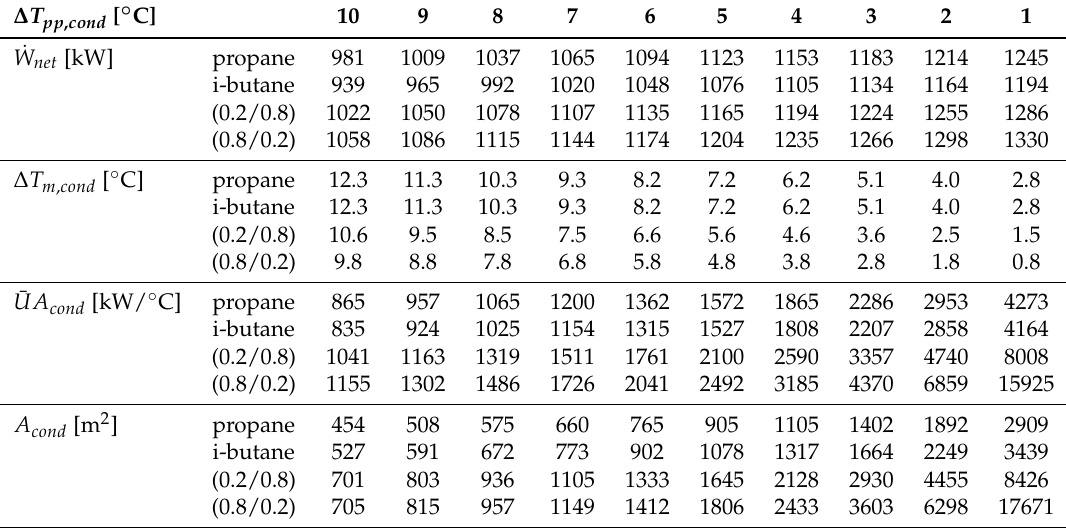
Table A1. Variation of net power output ( ˙ W net ), condenser mean temperature difference ( ∆ T m , cond ), condenser ¯ UA values ( ¯ UA cond ), and condenser areas ( A cond ) as functions of the condenser pinch point temperature difference ( ∆ T pp , cond ) for propane, i-butane and the mixtures propane/i-butane (0.2/0.8) and propane/i-butane